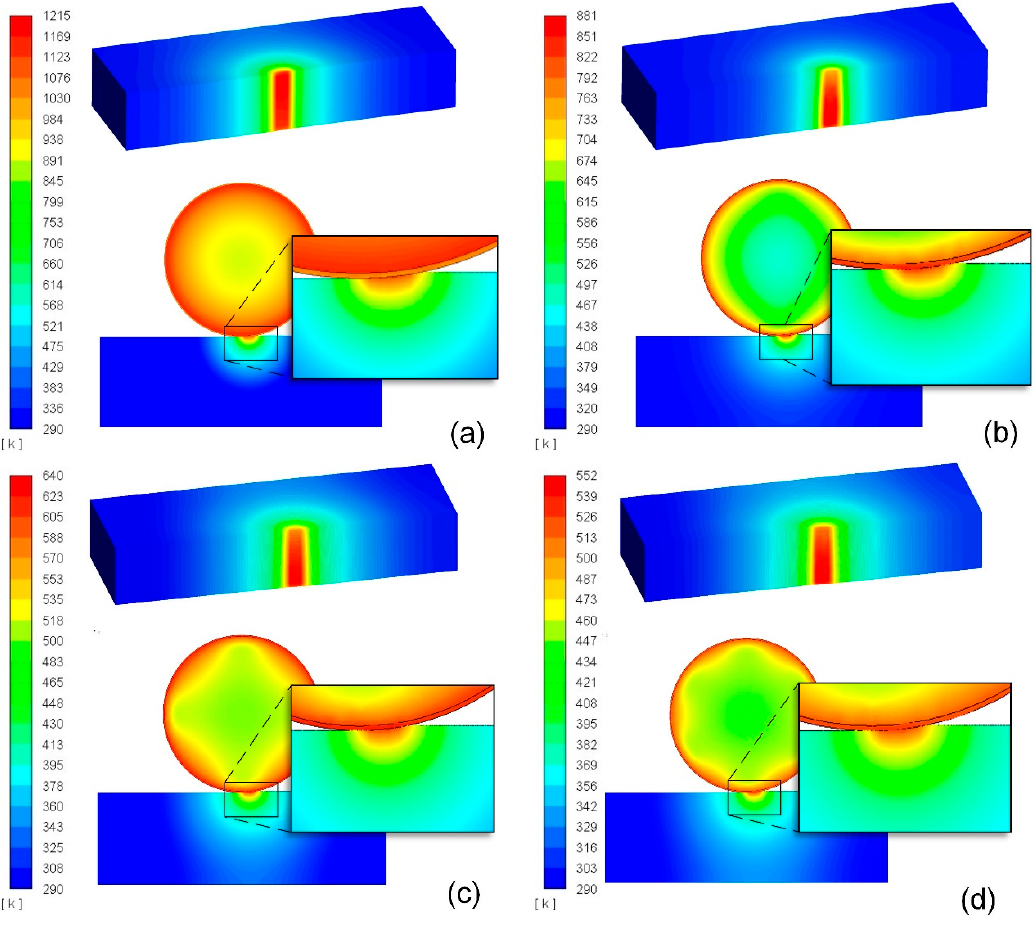
Figure 12. Temperature distribution on the workpiece under a grinding heat flux of 10 7 W / m 2 : ( a ) non-OHP, ( b ) 2 OHPs, ( c ) 4 OHPs and ( d ) 6 OHPs (Temperature unit: K).